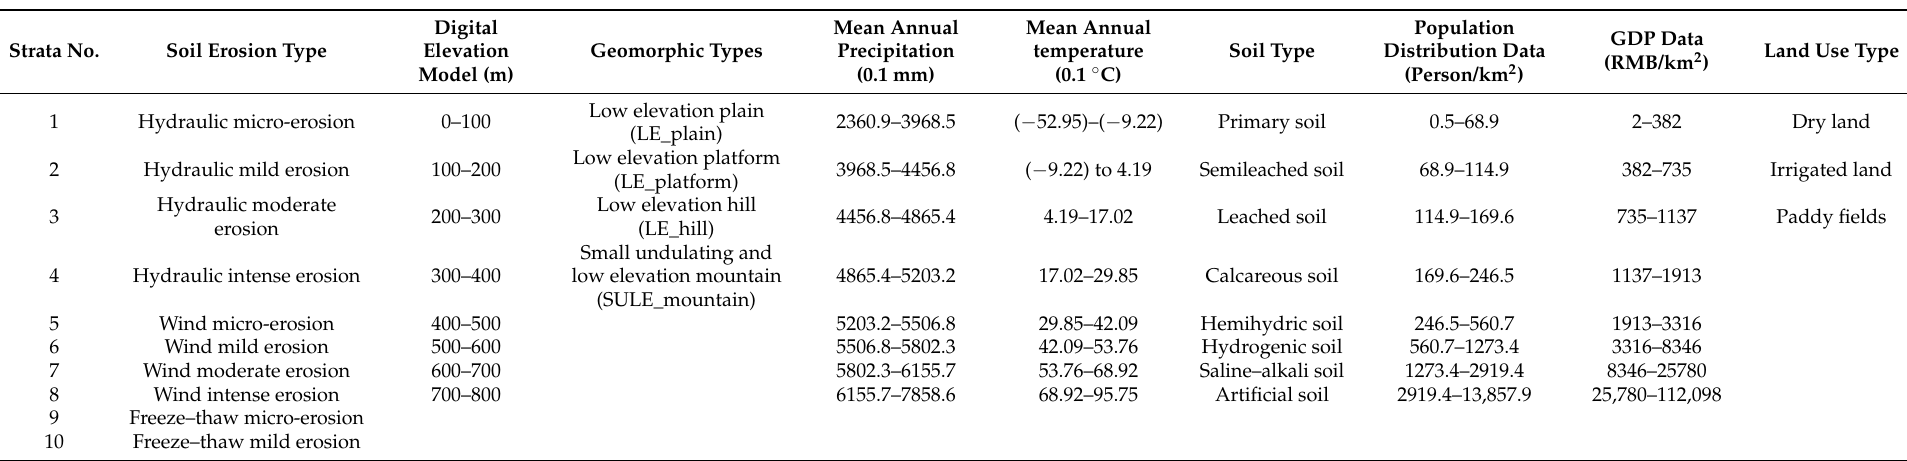
Table 1. Stratification of influencing